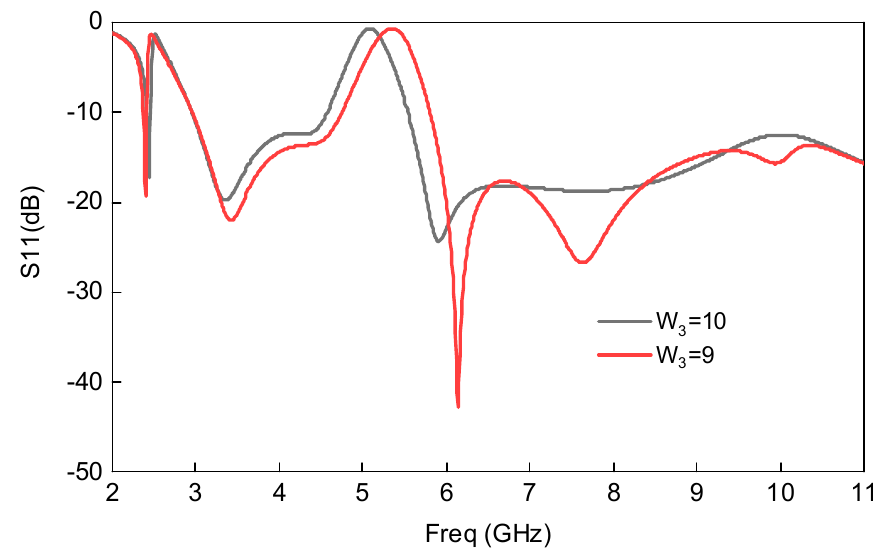
Figure 7. Effect of variable W 3 on the response of the antenna.